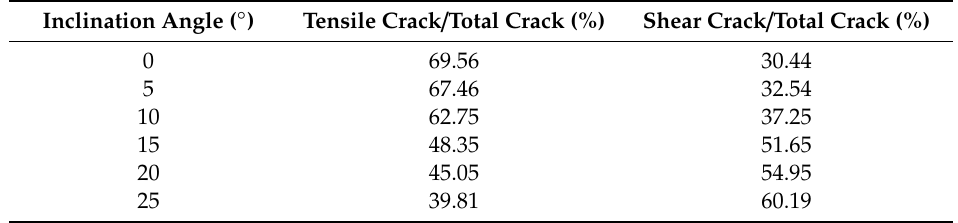
Figure 15. The proportion of tensile and shear cracks under different inclination angles at loading rate of 10 mm/min. Table 6. Proportion of tensile and shear cracks under different inclination angles at loading rate of 10 mm/min.